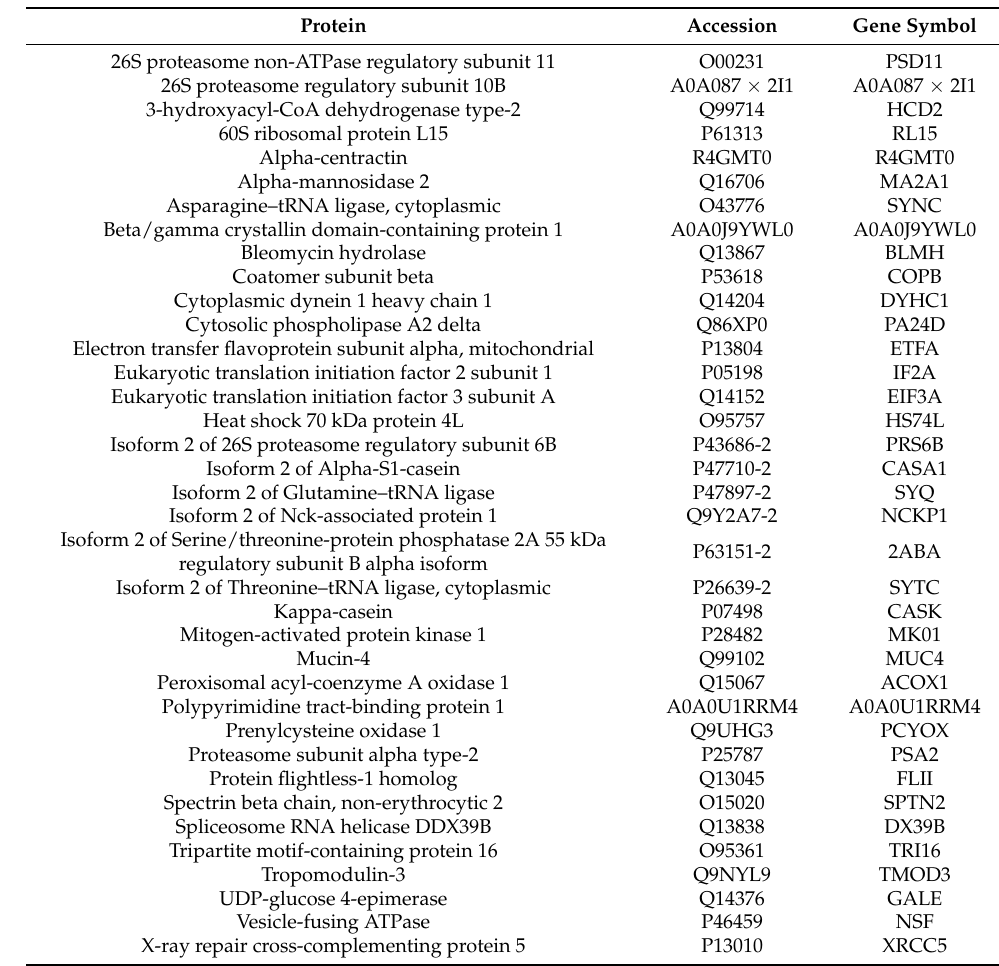
Figure 2. Pathway overview of the 35 most relevant proteins of the control group. Color codes (yellow) indicate a hit in the respective pathway. Higher color intensity (yellow) means a higher significance of one or more proteins within this signal cascade (FDR). Reactome Pathway database, open access open source [22]. Table 2. Significant proteins detected in the overactive bladder syndrome group.